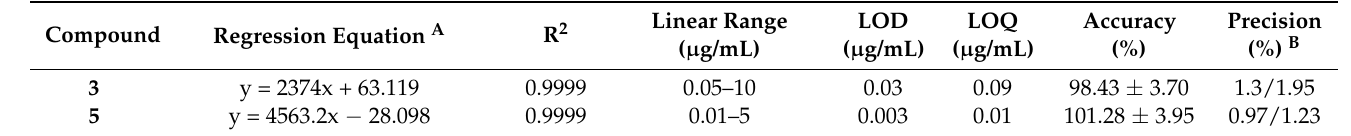
Table 7. Regression equation, linear range, limit of detection (LOD), limit of quantification (LOQ), accuracy, and precision obtained during optimization of the LC-PDA